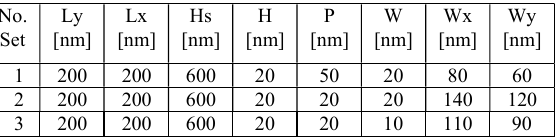
Table 1. Geometrical parameter used in 3 sets of 3D numerical investigations No. Set